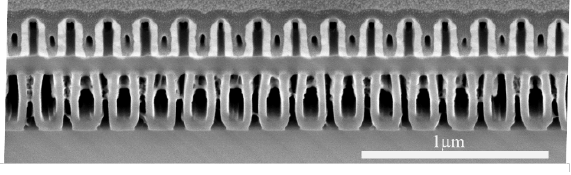
Fig. 3. Cross sectional SEM image of a layered grating structure. The upper layer consists of Ir and serves as linear polarizer, the lower layer consists of titanium dioxide and serves as